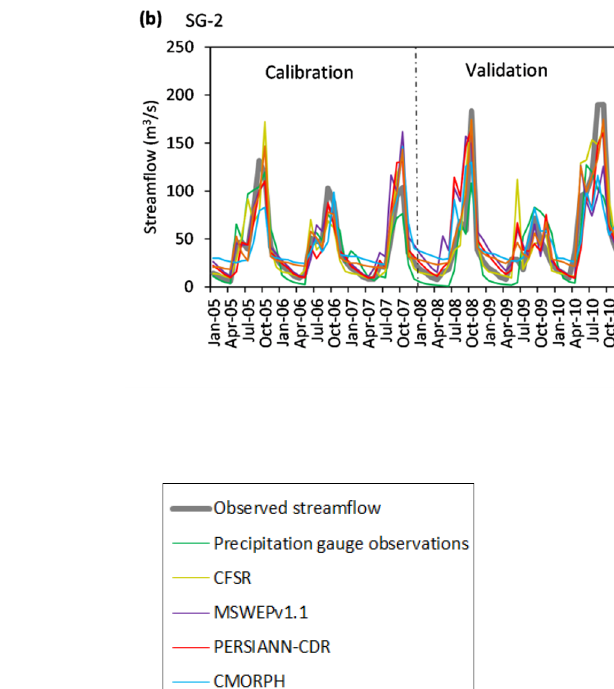
Water 2021 , 13 , x Figure 8. Comparison of simulated streamflow for different precipitation sources and observed monthly streamflow using Table 1. ( a ) SG-1, ( b ) SG-2, and ( c ) SG-3.